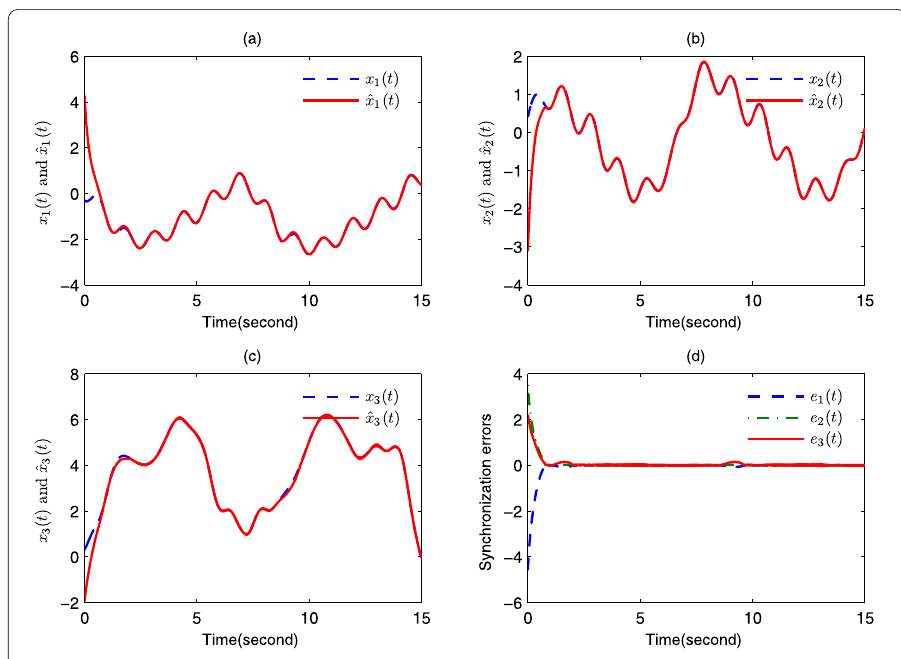
Figure 5 Simulation results when u ( t ) = [2sin(5 t ),2cos(5 t ),2sin(2 t )] T in ( a ) x 1 ( t ) and ˆ x 1 ( t ); ( b ) x 2 ( t ) and ˆ x 2 ( t ); ( c ) x 3 ( t ) and ˆ x 3 ( t ); ( d ) synchronization